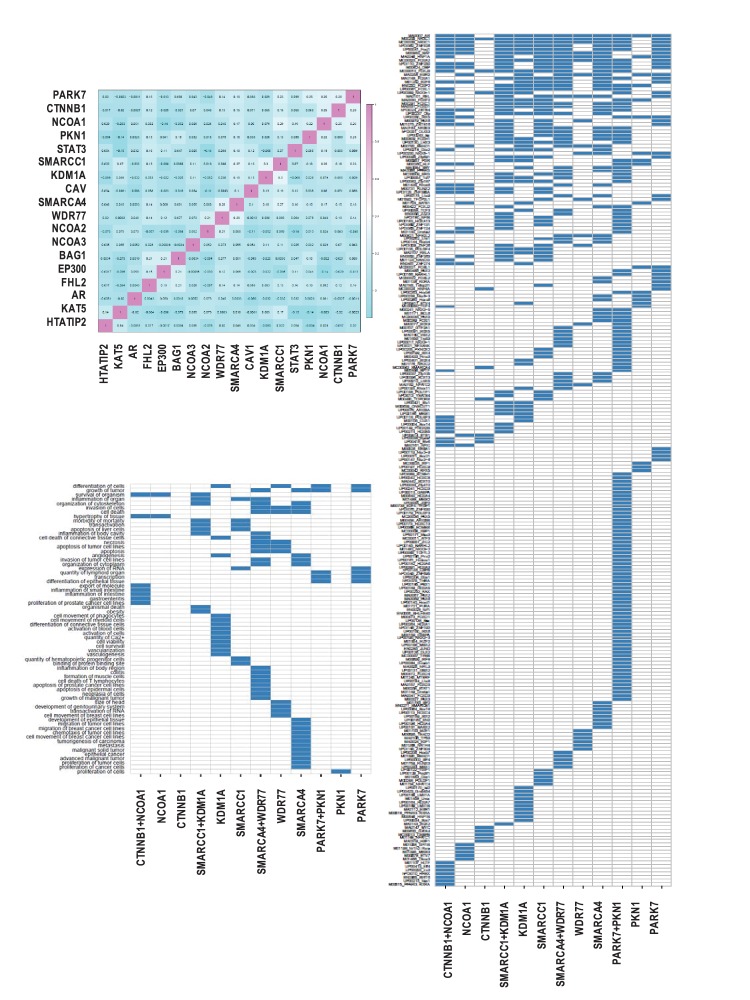
Correlation of coregulator-dependent androgen-responsiveness of AR target genes.(A) Pair-wise pearson correlation of coregulator-dependent androgen-responsiveness of AR target genes. For each pair of coregulators, the correlation was calculated based on the effect of loss of coregulator on androgen-regulation of AR target gene expression, as described in Supplementary file 5, panel A. (B) Cistrome analysis on ARBSs found in 4 pairs of AR target gene sets with the strongest Pearson correlation. AR target gene set pairs CTNNB1 +NCOA1, PARK7 +PKN1, SMARCA4 +WDR77 and SMARCC1 +KDM1A showed the strongest Pearson correlation of coregulator-dependent androgen-responsiveness, as shown in panel A. For each paired gene set, cistrome analysis was done on ARBSs from the individual AR target gene sets and on combined ARBSs found in both gene sets. The heatmap summarized the clustering of overrepresented TFBSs within and among ARBSs in the AR target gene sets. Blue bar, one overrepresented TFBS. (C) Ingenuity Pathway Analysis on gene signatures that are make up 4 pairs of AR target gene sets with the strongest Pearson correlation. AR target gene set pairs CTNNB1 +NCOA1, PARK7 +PKN1, SMARCA4 +WDR77 and SMARCC1 +KDM1A showed the strongest Pearson correlation of coregulator-dependent androgen-responsiveness, as shown in panel A. For each paired gene set, IPA identified the enriched functions annotations that are associated the individual AR target gene sets and the combined gene set. The heatmap summarizes the clustering of enriched functions within and among AR target gene sets. Blue bar, one enriched function term.